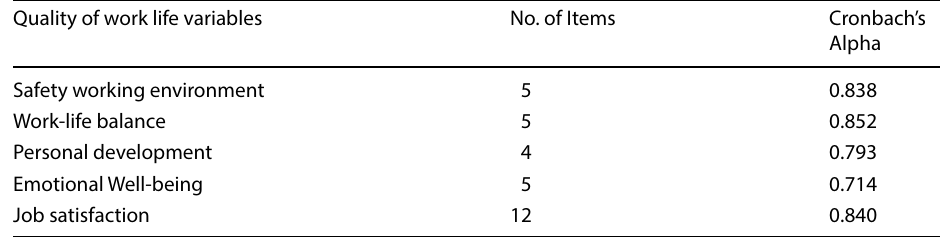
Table 1 Reliability of Scale and Cronbach’s Alpha of study